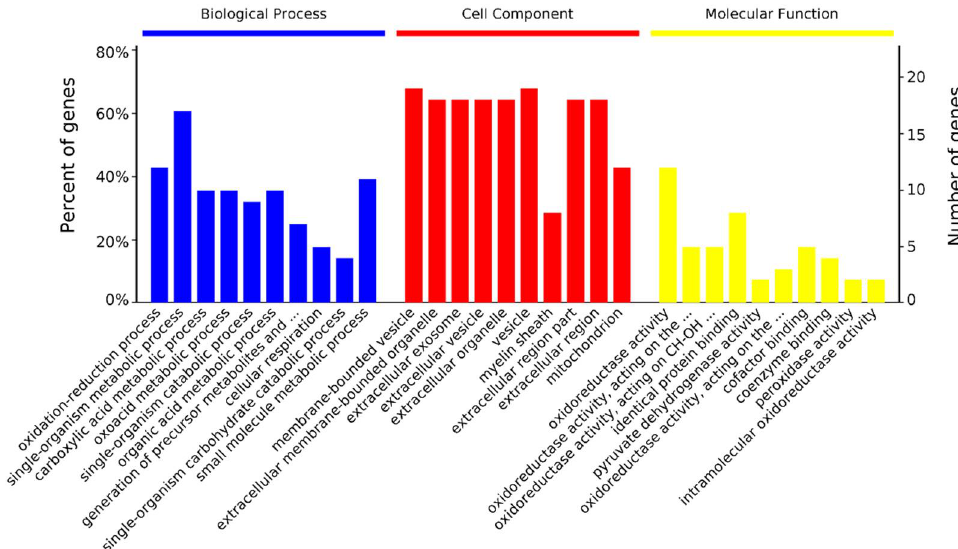
Figure 4. GO annotation of 39 differentially abundant proteins in three categories: biological process, cellular component, and molecular function at 28 vs. 42 day. Only the terms with p -values less than 0.05 are listed.